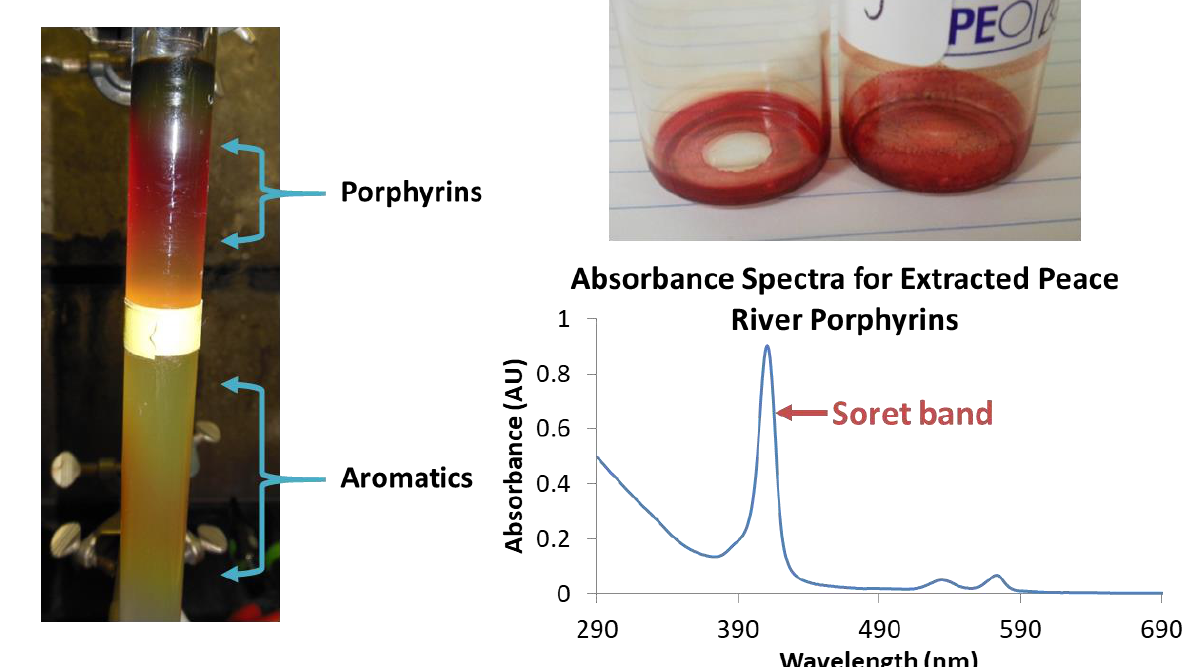
Figure 2. Porphyrins were extracted from Peace River bitumen using column chromatography ( left ), which was dried to give a red-colored porphyrin fraction ( upper right ). This material was analyzed by UV-Visible spectroscopy, which shows the presence of a strong Soret band at 410 nm, confirming the presence of porphyrins. Bands above 500 nm are associated porphyrin Q bands.